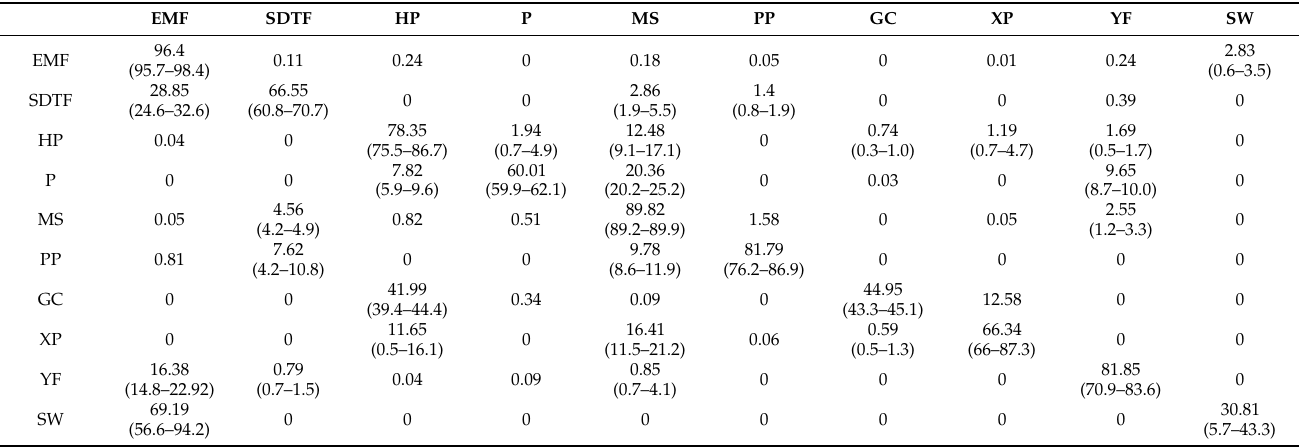
Table 4. Biome migration matrix from the present (1981–2010) to the future (2035–2065) in percentage using the median of the 3 RCMs. The results in parentheses show the relative extent min–max of biomes that